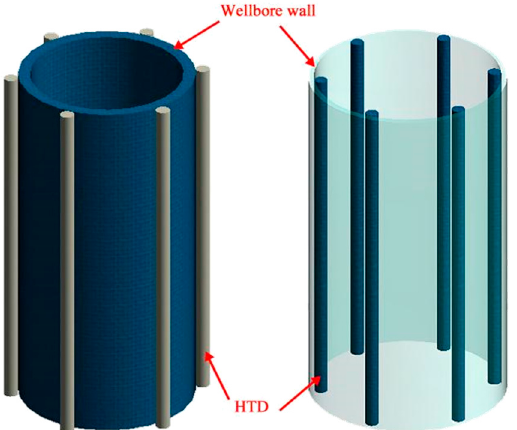
Figure 2. The connection between the HTD and the wellbore